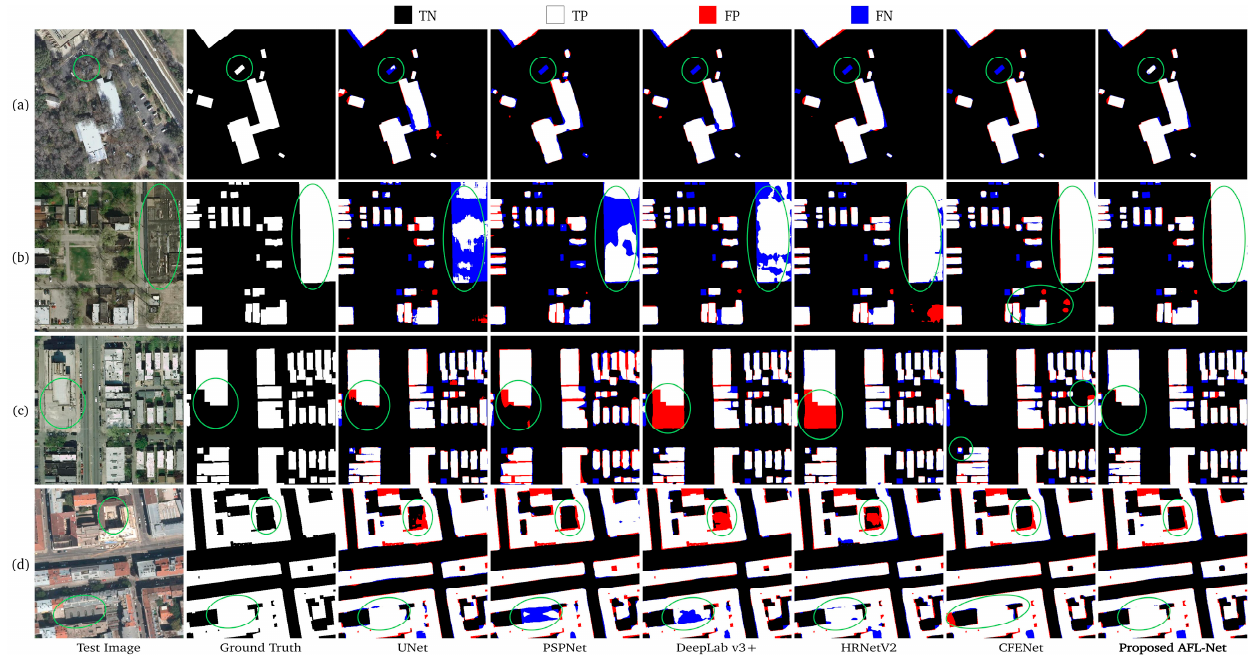
Figure 10. ( a – d ) Sample building segmentation results from the selected models with the Inria dataset (comparative experiment).